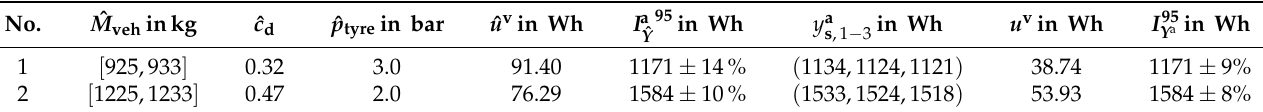
Table 3. Test data set with model uncertainties of WLTC depending on application parameters θ a